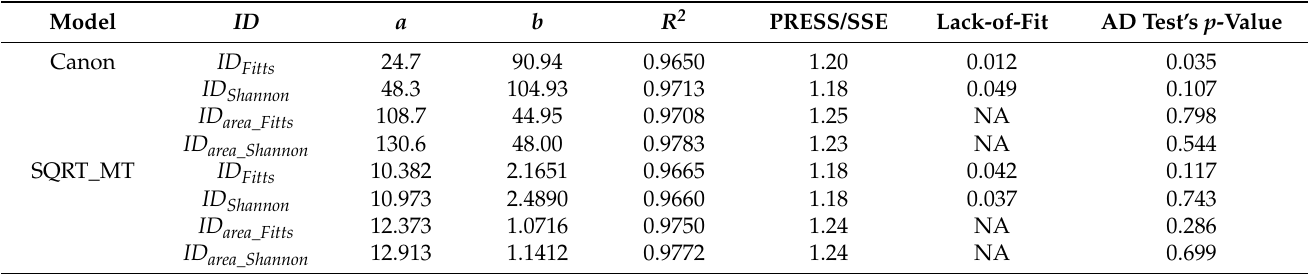
Table 11. Regression analysis for the amplitude of 256 pixels. ID area_Shannon had the best R-square and PRESS in both the Canon and the SQRT_MT models.